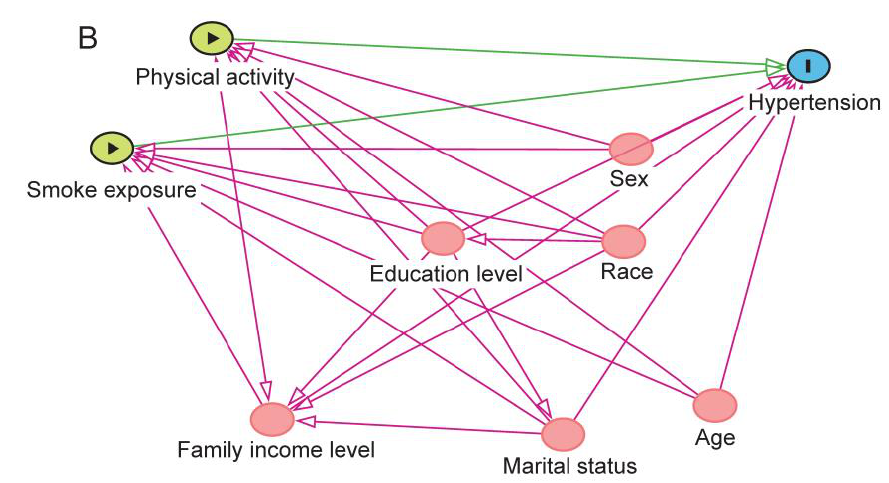
Figure 1. DAG for selecting confounders. ( A ) DAG for the associations among SE, PA, and hy- pertension, showing all potential confounders. ( B ) DAG for the associations among SE, PA, and hypertension, showing the confounders used in the final models. Pink lines indicate potential confounders, and green lines indicate potential mediators. Abbreviations: DAG, directed acyclic graph.